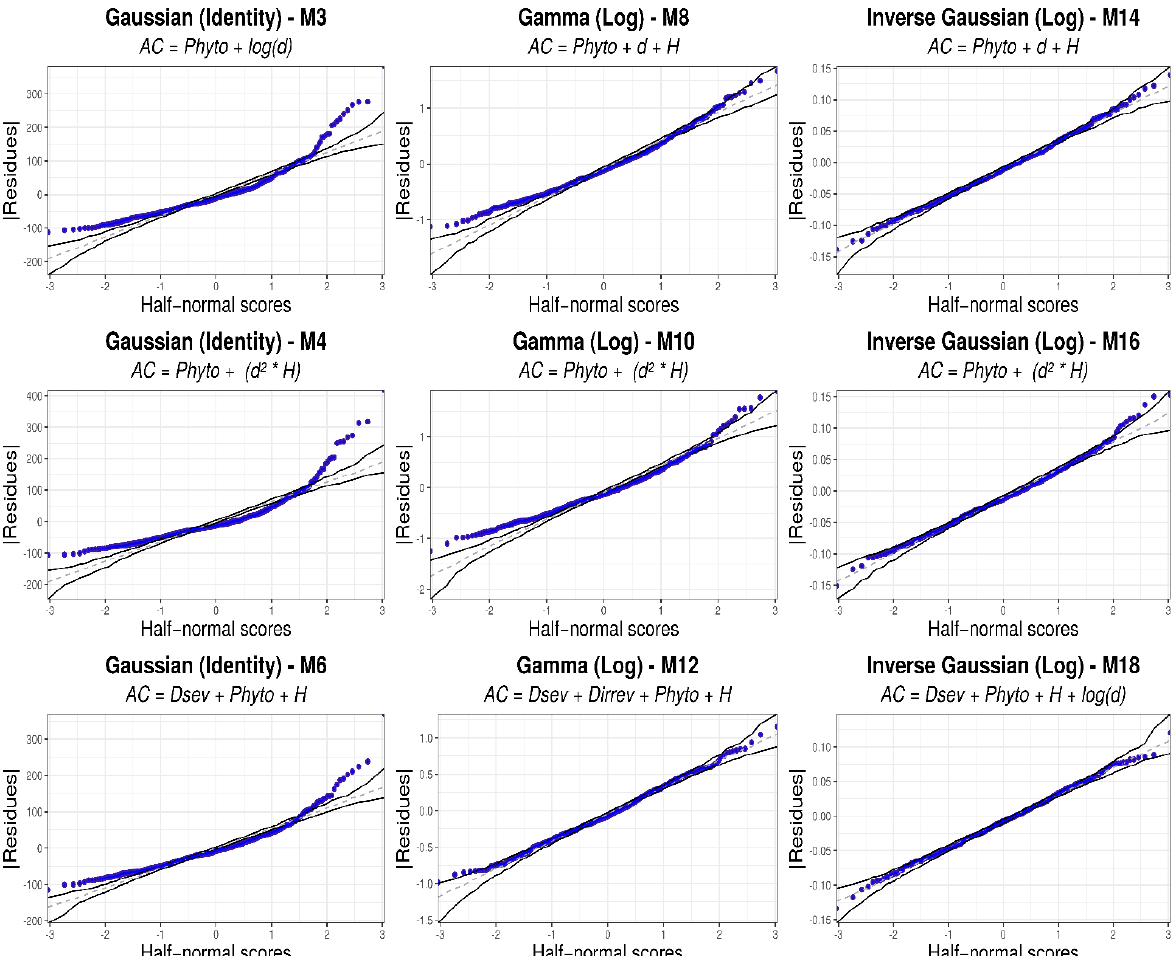
Figure 5. Half-normal plots with simulated envelope for the deviation residuals of the six models with the best fitting. Predictors indicative of the amount of irreversible or severe damage to trees were more important in describing the effects on the response variable. For the M12 model, the half-normal plots showed residuals inside the simulated enve-lope, indicating a good fit of the model to the data. AC = area of the clearing; Phyto = phytophysiognomy; d = diameter at breast height; H = height; Dirrev = number of trees with irreversible damage; Dsev = number of trees with severe damage; log = logarithmic